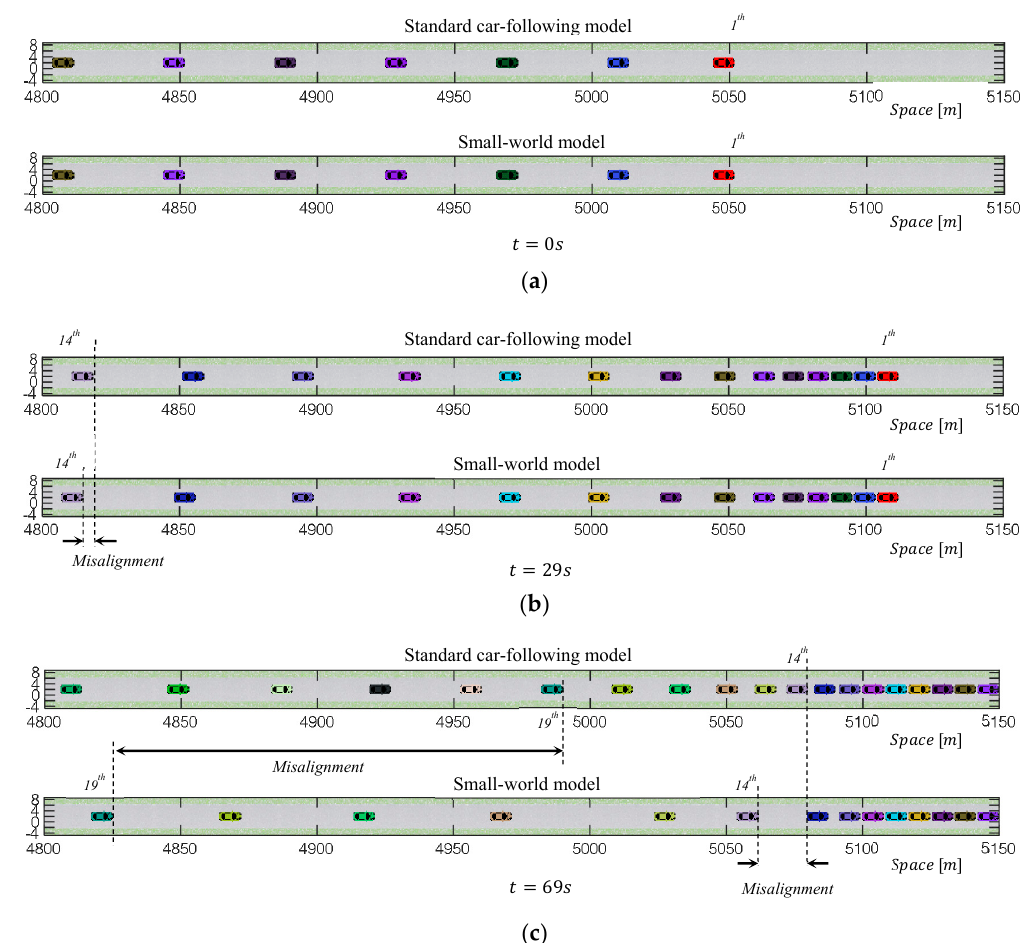
Figure 17. The standard car-following and small-world models are compared in the space domain: ( a ) the start alignment at t = 0 s; ( b ) the time frame at t = 29 s; ( c ) the time frame at t = 69 s.